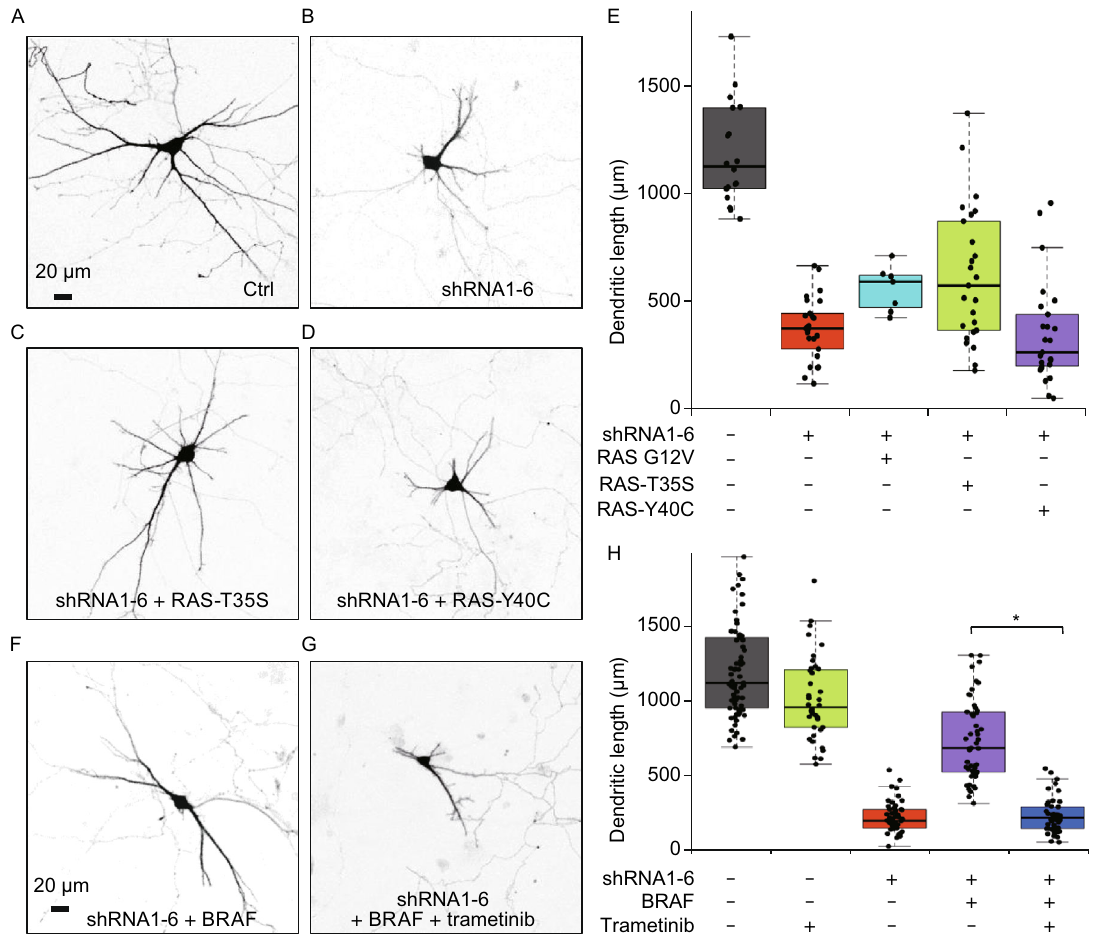
Figure 3. RAS-RAF-MEK signaling pathway protects against dendritic atrophy caused by DYNC1I1 de fi ciency. (A – D) Dominant active mutant G12V of RAS and selective RAF-activator mutant (G12V, T35S) of RAS protect against dendritic atrophy caused by DYNC1I1 knockdown, while selective AKT-activator mutant (G12V, Y40C) of RAS has no effect. Primary hippocampal neurons are transfected with control vector (Ctrl) or shRNA1-6 co-transfected with RAS-G12V, RAS-G12V-T35S or RAS-G12V-Y40C at DIV6, and imaged at DIV11. The scale bars represent 20 μ m. (E) Scatterplots with boxplots show the total dendritic length distribution of neurons transfected with control vector (Ctrl, n = 18, gray), shRNA1-6 ( n = 25, red), shRNA1-6 with RAS-G12V ( n = 7, light blue), RAS-G12V-T35S (RAS-T35S, n = 25, green) or RAS-G12V-Y40C (RAS-Y40C, n = 25, purple). (F and G) Trametinib, a speci fi c inhibitor of MEK kinase in RAS-RAF-MEK signaling, inhibits the protective role of BRAF in dendritic atrophy caused by DYNC1I1 de fi ciency with shRNA1-6. Neurons are co-transfected with BRAF and shRNA1-6 at DIV6, and imaged at DIV11. The scale bars represent 20 μ m. (H) Scatterplots with boxplots show the total dendritic length distribution of neurons transfected with control vector treated without ( n = 69, gray) or with 100 nmol/L of trametinib ( n = 40, green), shRNA1-6 ( n = 50, red), shRNA1-6 co- transfected with BRAF treated without ( n = 50, purple) or with 100 nmol/L of trametinib ( n = 50, blue). *, P